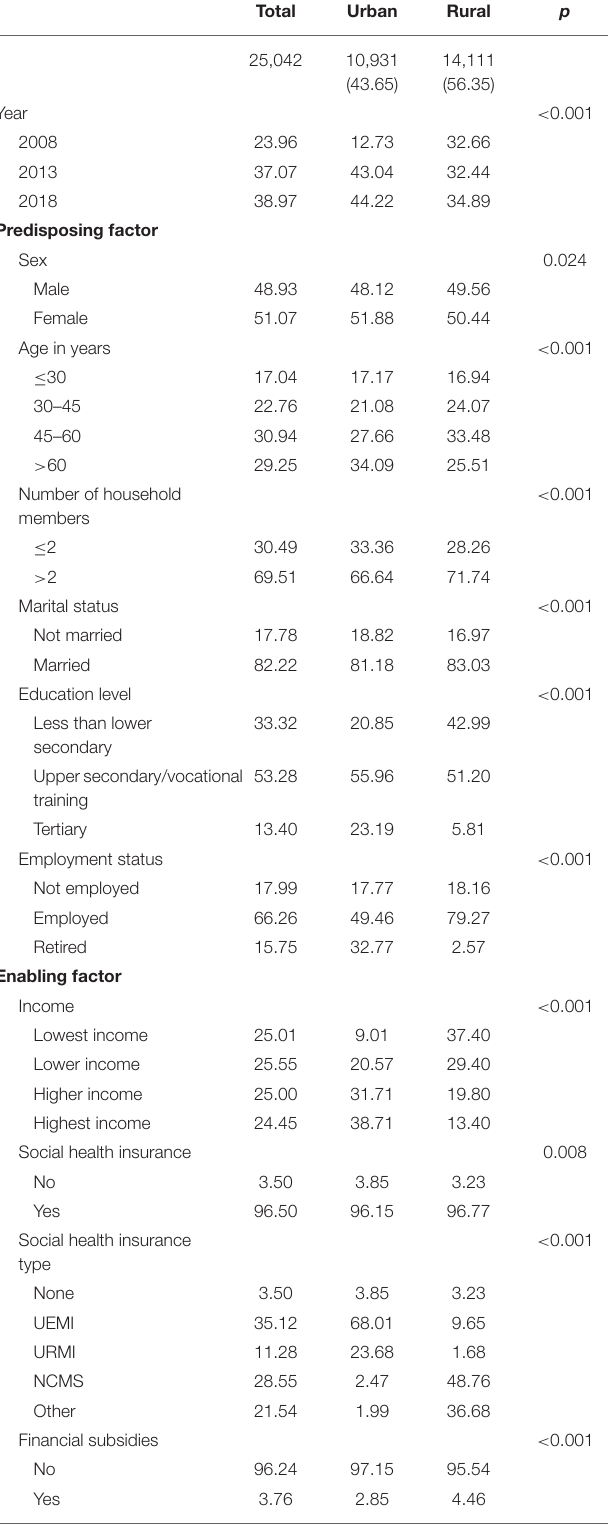
TABLE 2 | Characteristics of the study population according to area of residence (urban vs. rural). Total Urban Rural